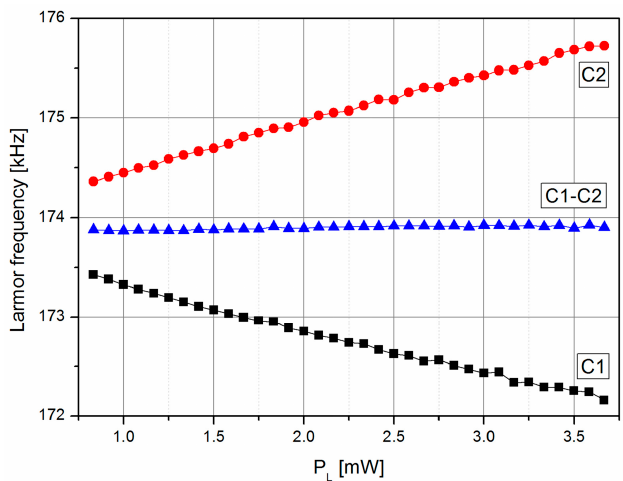
Figure 6. Dependence of the resonance frequencies of the two single cells and the zero crossing frequency of the LSD-Mz signal on the laser pumping power P L .